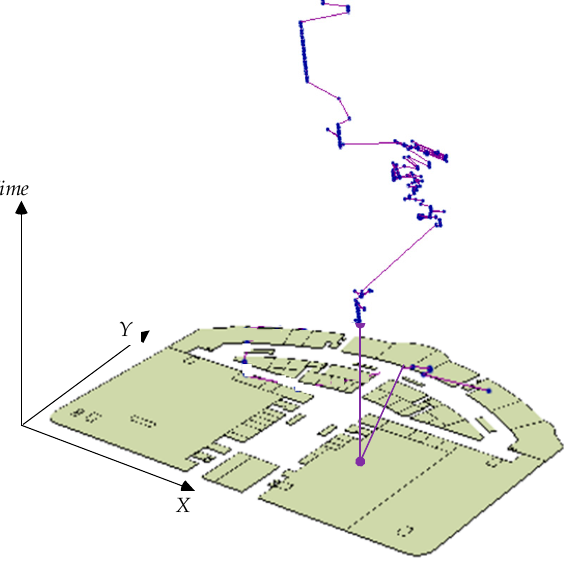
Figure 4. Pedestrian Trajectory ( Tr ) .